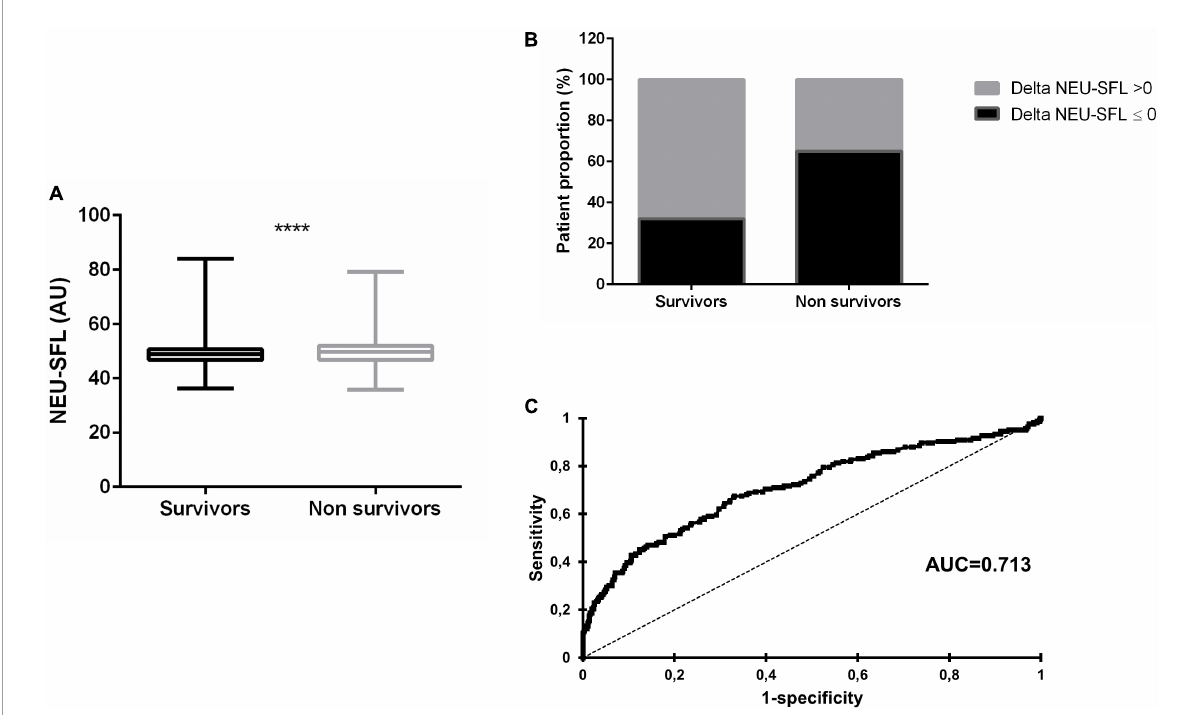
FIGURE2 Fatal COVID-19 is associated with initially higher and increasing NEU-SFL values during hospitalization. (A) Boxplot representation of NEU-SFL at admission in survivors ( n = 1 564) and non-survivors ( n = 288). Results are represented with medians and ranges. AU, arbitrary unit. (B) Comparison of Delta NEU-SFL distribution between the hospital entry and the last day of hospitalization in hospitalized COVID-19 survivors and non-survivors. For positive Delta NEU-SFL values, n = 385 for survivors and n = 58 for non-survivors. For null or negative Delta NEU-SFL values, n = 181 for survivors and n = 108 for non-survivors. A positive delta NEU-SFL corresponds to a decrease in NEU-SFL values between admission and the last day of hospitalization; a negative delta-NEU-SFL corresponds to an increase in NEU-SFL between admission and the last day of hospitalization. (C) Receiver operating characteristic curve between Delta NEU-SFL and in-hospital survival. Delta NEU-SFL: absolute difference between the NEU-SFL index value at admission and the last available one. AUC, area under the curve. **** p <